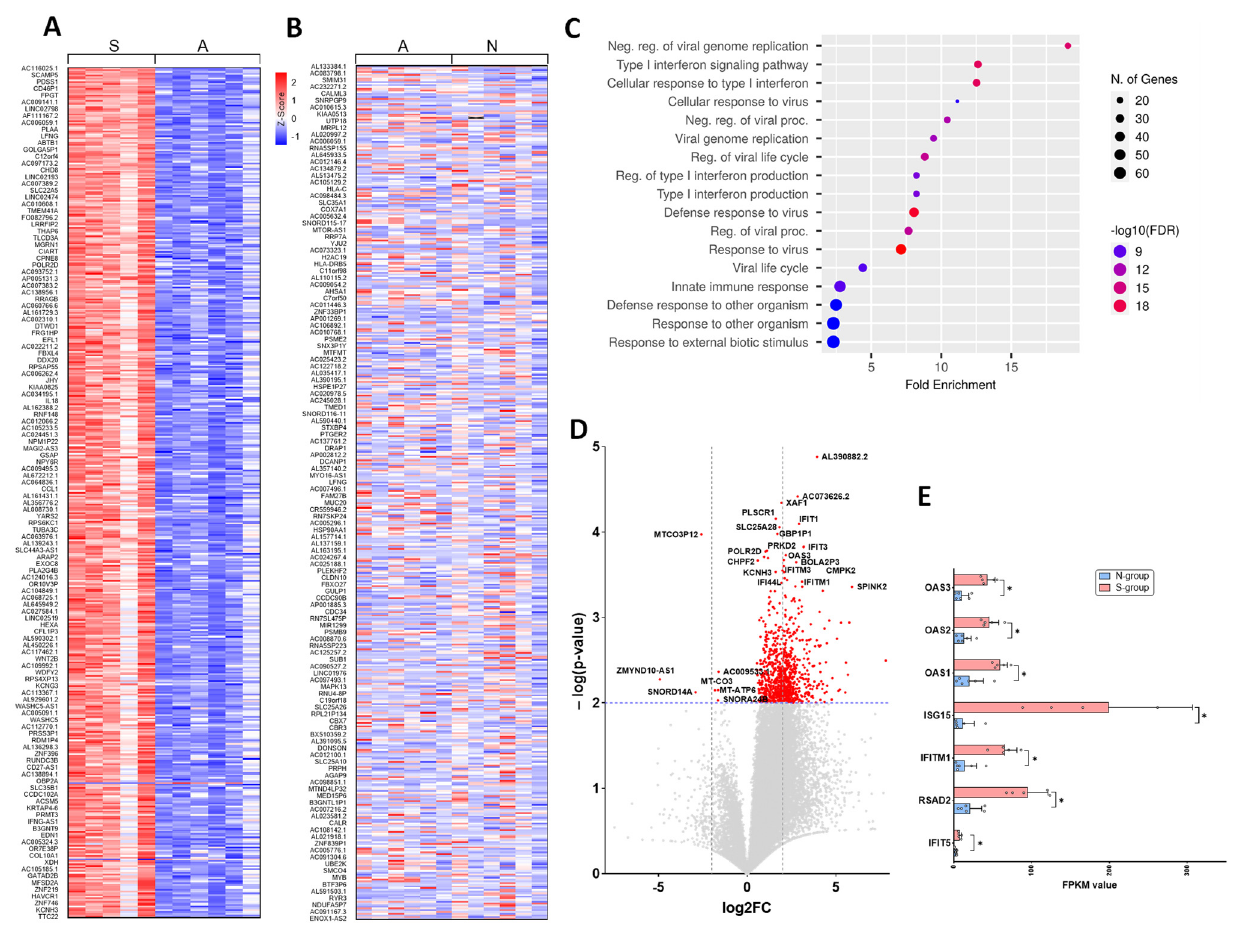
Figure 1. Transcriptomic analysis showing the activation of type I interferon in severe COVID-19. ( A ) Heat map of the transcriptome of patients with severe COVID-19 (S-group) in comparison with mild/asymptomatic COVID-19 (A-group), ( B ) comparison between mild/asymptomatic COVID-19 (A-group) and negative (N-group). ( C ) Bar plot showing the enrichment analysis of genes significantly represented in severe COVID-19 (S-group) as compared to Negative (N-group) samples. ( D ) Volcano plot depicting the significantly ( p -value < 0.01) differentially upregulated and downregulated genes in severe COVID-19 (S-group) as compared to negative (N-group) patients. ( E ) Bar plot showing the individual interferon stimulated genes upregulated in severe COVID-19 (S-group). * p <